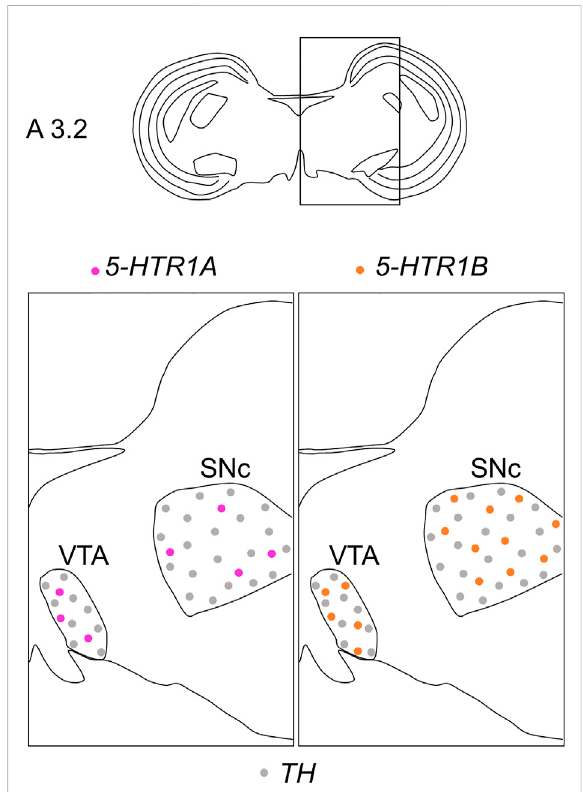
FIGURE 7 Schematic summary of the expression patterns of 5-HTR1A or 5-HTR1B and TH in dopaminergic nuclei in the P1 chick midbrain. Representative expression patterns in sections around A 3.2 are exhibited in colored areas (magenta, 5-HTR1A ; orange, 5-HTR1B ; grey, TH ). The alternating dotted pattern indicatesthatthecellsweresparselydistributedwithalternating 5- HTR1A (or 5-HTR1B ) and TH signals but no double positive signal. The levelsofexpressioninsections wereinaccordancewith those mentioned in the Kuenzel and Masson ’ s chick atlas (Kuenzel and Masson, 1988). P1, post-hatch day 1; SNc, substantia nigra pars compacta; VTA, ventral tegmental